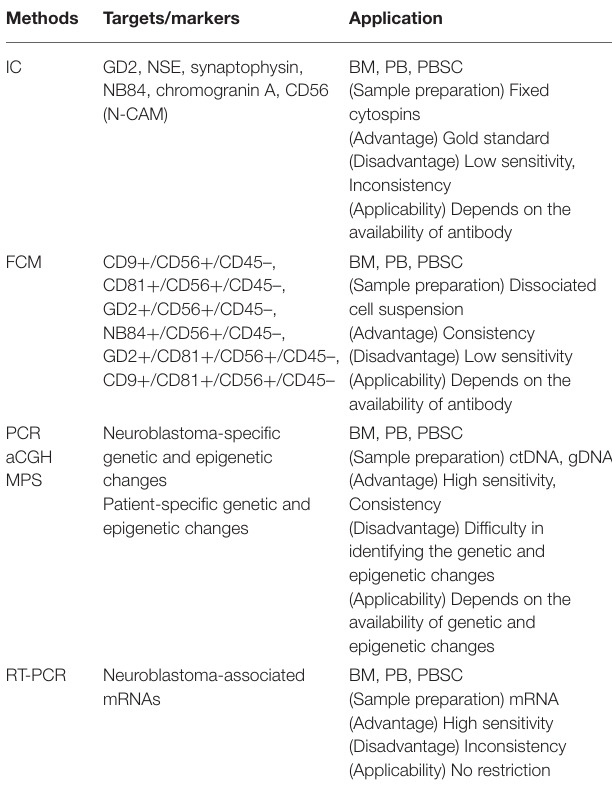
TABLE 1 | Comparison of neuroblastoma MRD detection